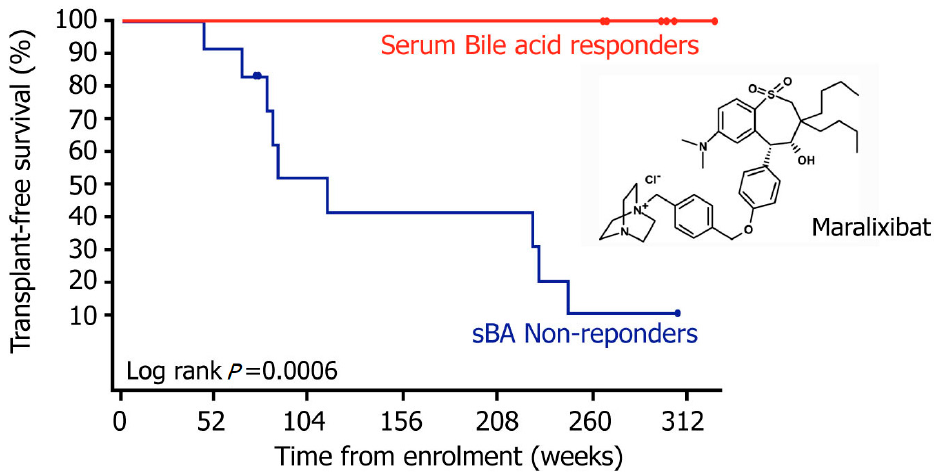
Figure 5. Median overall survival rate among the PFIC2 patients. This graph shows the median overall transplant-free survival rate among the PFIC2 patients, using Kaplan–Meier curve analysis, for those patients that had a significant sBA decrease, designated as sBA responders (red), compared with those patients that showed an insignificant sBA change, designated as sBA non-responders (blue). The X -axis represents weeks and the Y -axis represents the percentage of patients that were